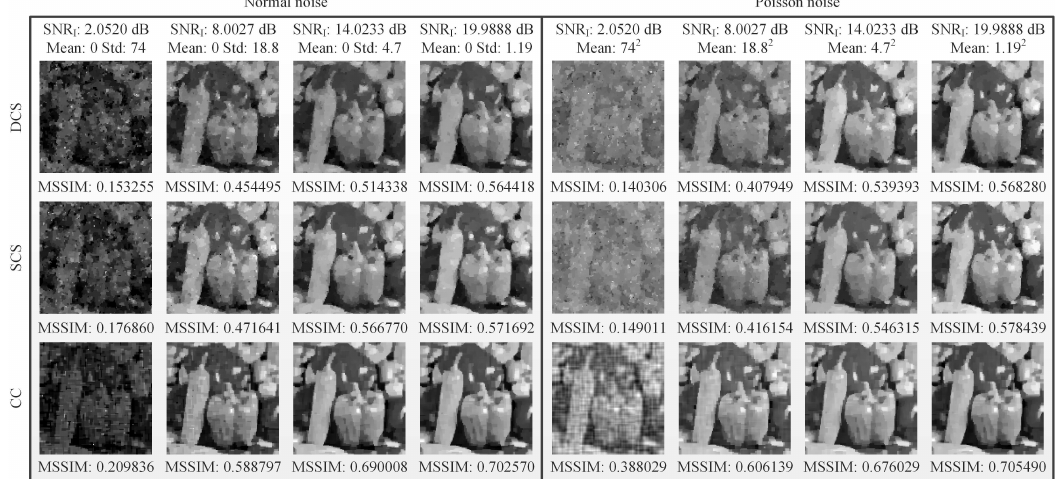
Figure 6. Influence of different noise on the image reconstructions, using DCS, SCS and CC methods. obeying Poisson distribution. All recovered images are of 128 × 128 pixels, with a 12.5% sampling